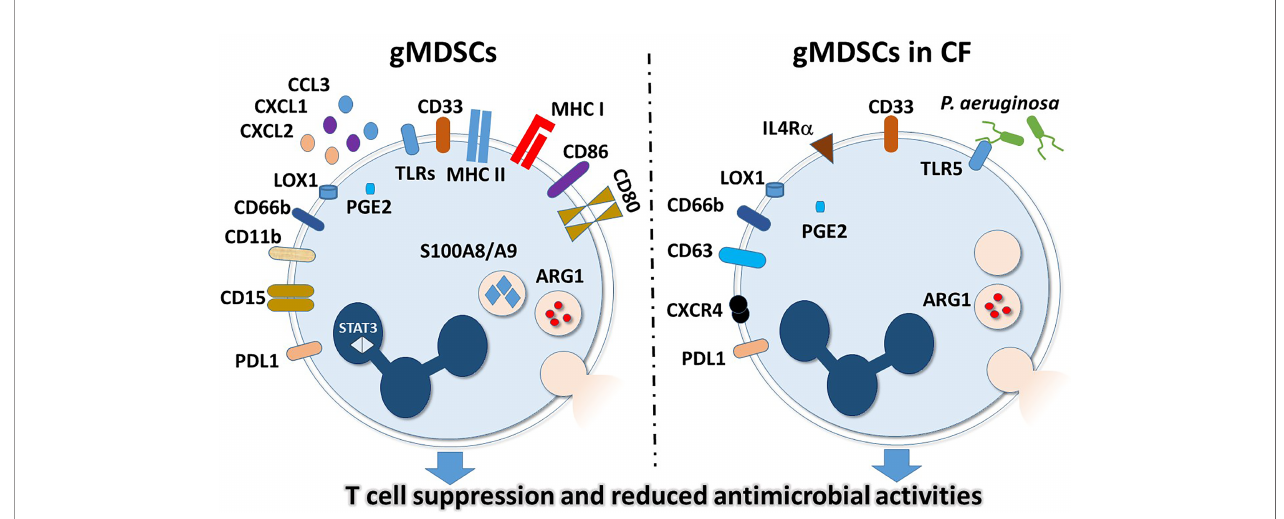
FIGURE 1 | General and CF-speci fi c features of gMDSCs. Surface markers and intracellular molecules are indicated that have higher expressions or activities in granulocytic MDSCs in general (left panel) or in gMDSCs in CF (right